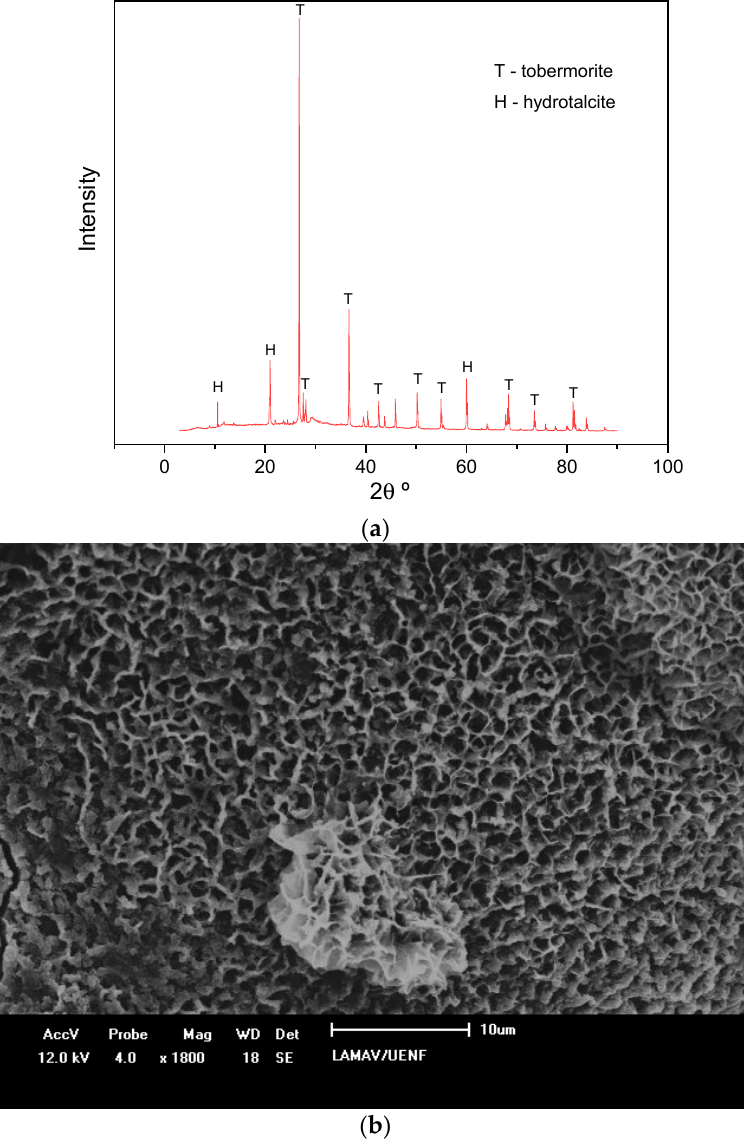
Figure 8. ( a ) XRD; ( b ) SEM of the composition with 10% sodium.